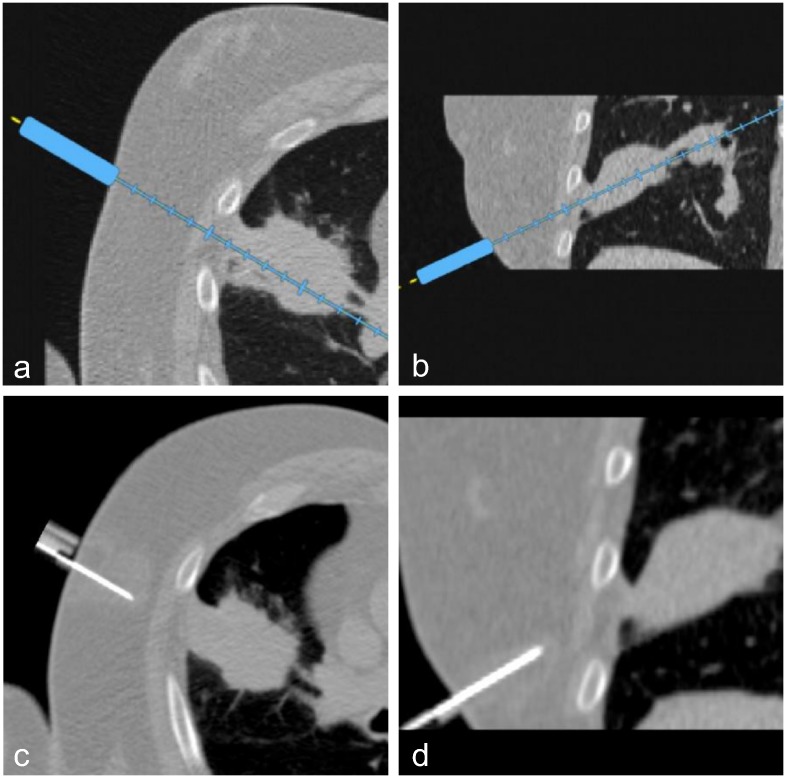
Illustration case (NAV).This 65 year old male patient had a record of lung carcinoma with recurrence after chemotherapy. There was a collegial indication for a percutaneous CT-guided biopsy for immunohistochemical (IHC) characterization. The patient gave written informed consent. The operator (senior) predicted an easy intervention. The patient was randomized to the NAV group. Planning was performed using the navigation system directly on the patient, with a double angulated intercostal trajectory (a, b). The first control acquisition showed the achieved trajectory (c, d) to be very similar to the planned trajectory (step Δ1). Two more control acquisitions were necessary to reach the target (step Δ2), and perform the biopsy. No adverse event was reported. Pathologic findings on the biopsy sample showed an Anaplastic Lymphoma Kinase (ALK) negative acinar adenocarcinoma of the lung.